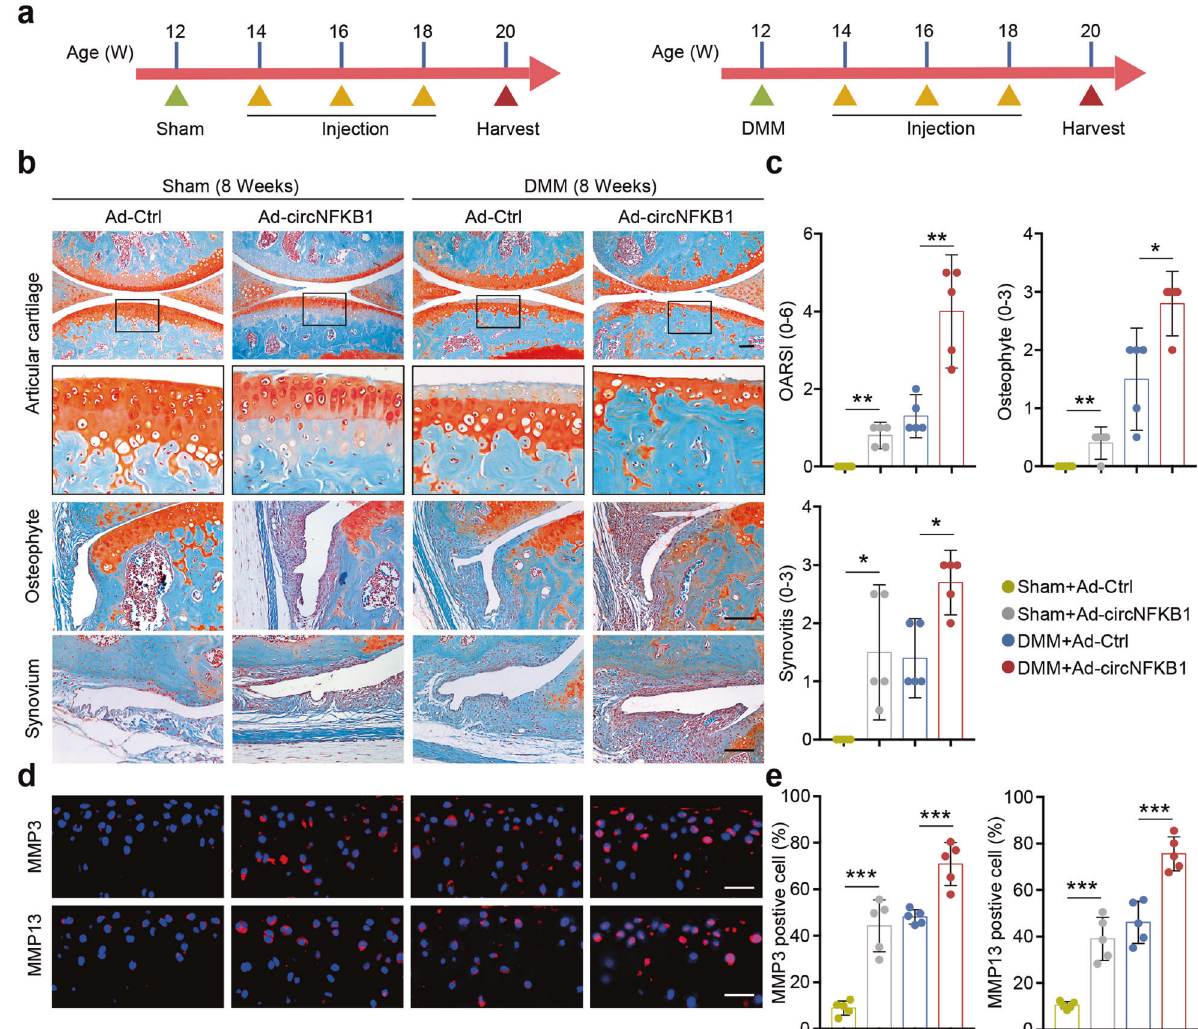
Fig. 5 Overexpression of circNFKB1 aggravates OA progression in DMM surgery-induced OA mouse model. a Schematic illustration of circNFKB1 delivery schedules in sham mice or DMM mice. b Safranin-O/fast green staining of the cartilage (upper panels), osteophyte (middle panels), and synovium (lower panels) ( n = 5 mice). Scale bars, 100 μ m. c Scoring of OARSI, Osteophyte, and Synovitis in sham- or DMM- operated mice subjected to IA injection with Ad-Ctrl or Ad-circNFKB1. ( n = 5 mice per group). Scale bars, 50 μ m. d Immuno fl uorescence staining of MMP3 (upper panels) and MM13 (lower panels) of chondrocytes in the indicated groups at 8 weeks after fi rst injection or DMM surgery ( n = 5 mice). Scale bars, 50 μ m. e Quanti fi cation of MMP3 and MMP13 positive cells were performed according to staining results ( n = 5 per group). Mean values ± 95% con fi dence interval (CI) with Mann – Whitney U test for c . For e , mean values ± SD are shown, and p values were calculated by two-tailed Student ’ s t test. * p < 0.05, ** p < 0.01, *** p < 0.001, **** p < 0.0001, ns, not signi fi cant. b , d , representative images are